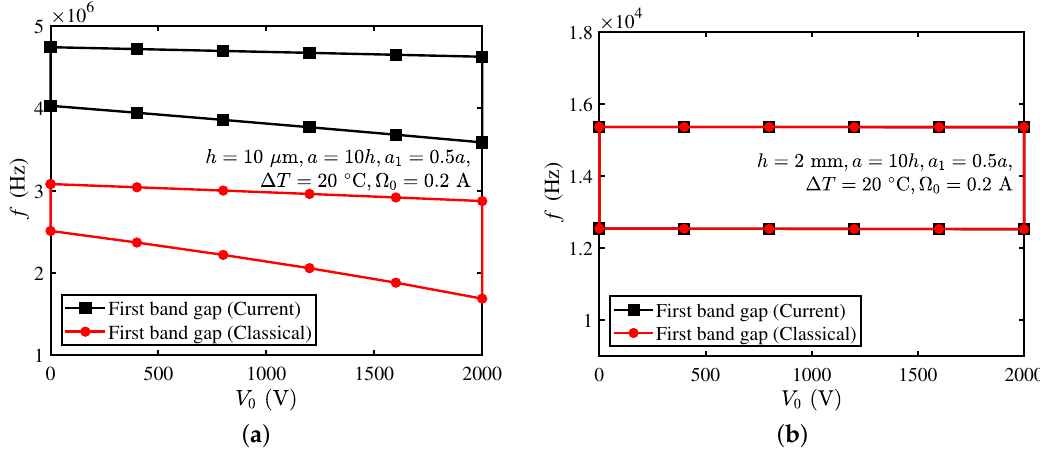
Figure 7. Bandgaps of current and classical models under different external electric potentials with ( a ) h = 10 µ m, and ( b ) h = 2 mm.